Question: Write a single sentence explaining what this figure depicts.
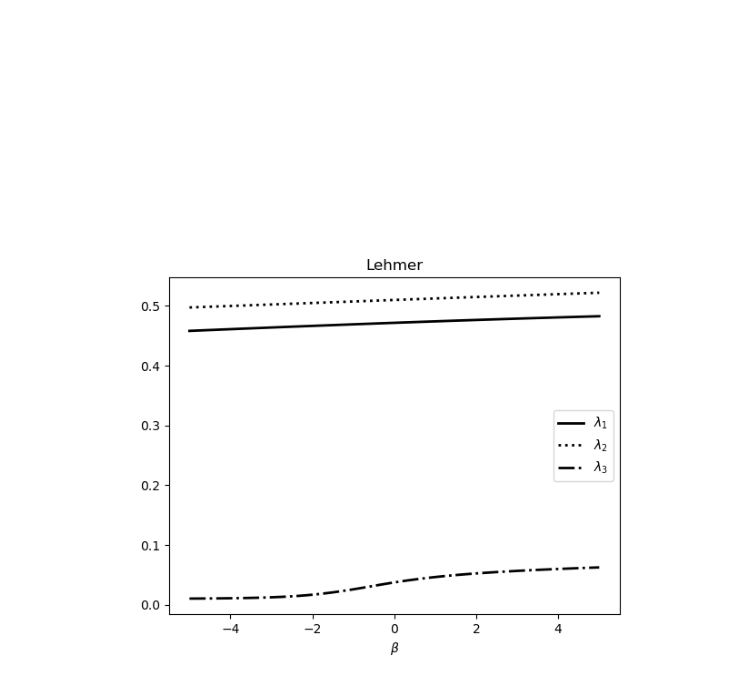
Answer: MWLE of λ as the Lehmer’s mean as function of β